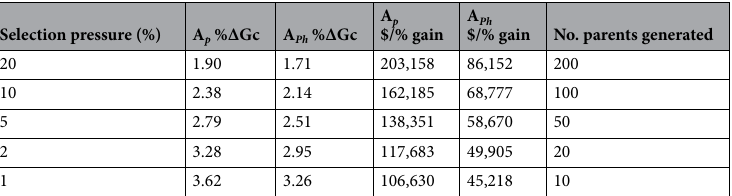
Table 5. Simulated predictions of percentage genetic gain per cycle (3 years) of selection (%ΔGc) and cost per percentage of predicted genetic gain ($ per % gain), using among half-sib (A p ) family selection, for dry matter (DM) yield based on the 1000 HS family data (evaluated across years, seasons and locations), from DM cuts (A p ) and phenomics based phenotyping (A Ph ). Selection pressure (%) and the associated number of selected parents are indicated. $, New Zealand dollars. These results are based on the estimated variance components from REML analysis, used as starting points for simulation of breeding methods. Ph *, LiDAR based phenomics accuracy = 0.90.